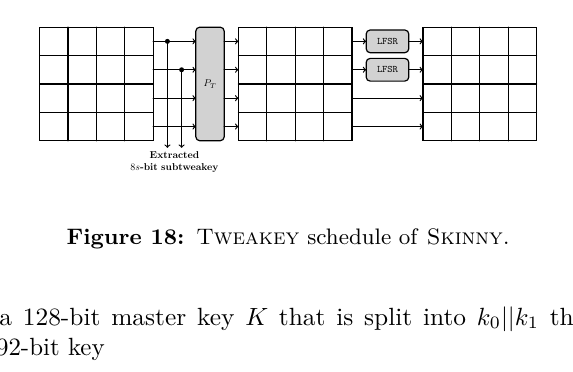
Figure 17: Round function of the tweakable block cipher Skinny .